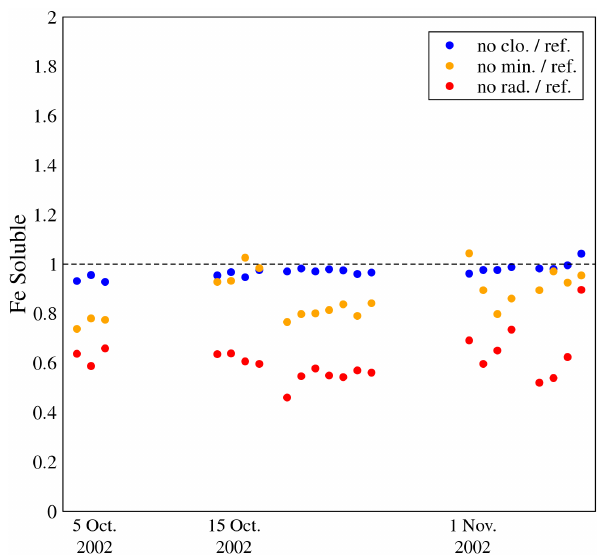
Fig. 7. Ratios of iron soluble concentrations without/with clouds (blue dots), without/with variable mineralogy (orange dots), and without/with radiation (red dots) included